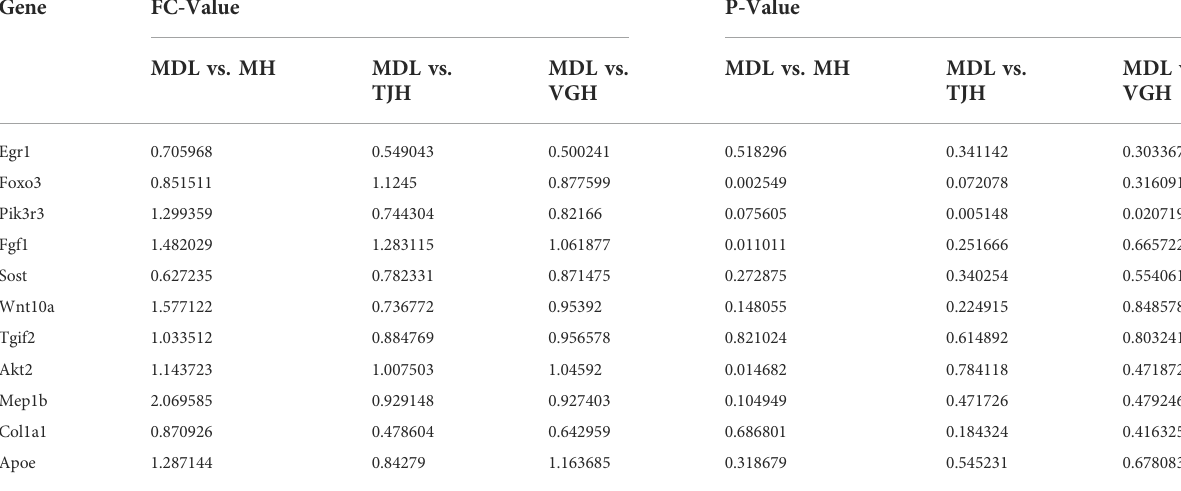
TABLE 3 Regulation of multi-bioactive compounds combination on differential candidate